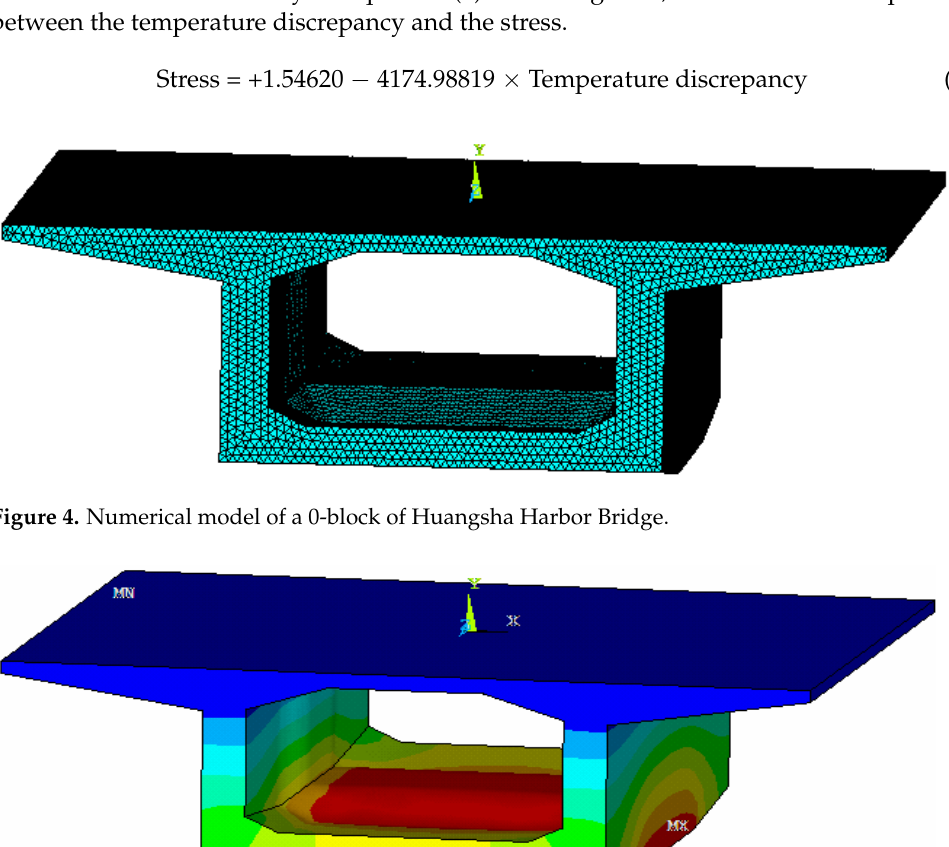
Figure 5. Calculated temperature field on the 0 ‐ block (Unit: °C).